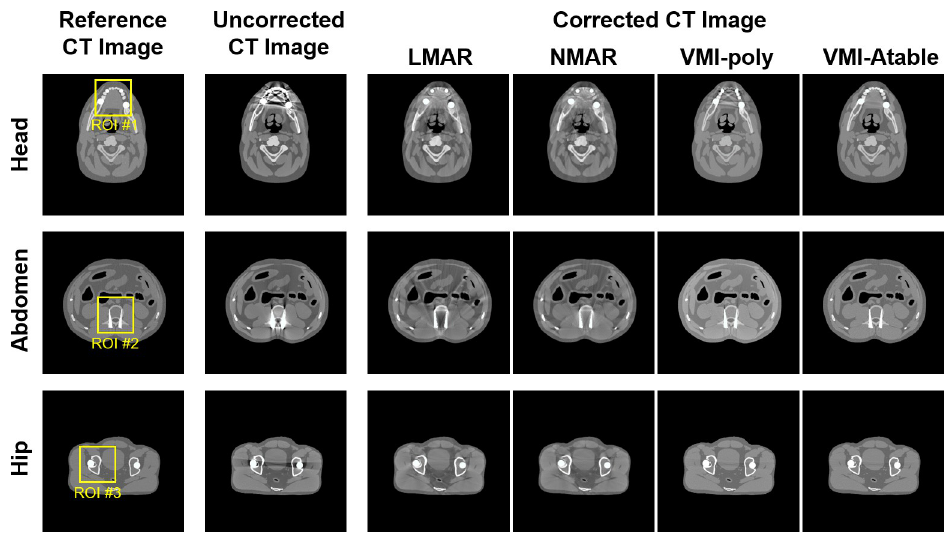
Fig 8. Simulated results using the XCAT phantom for evaluating the different MAR methods. Each row corresponds to a different part of the human body. The columns represent the reference CT image; uncorrected CT image with metal artifacts; and corrected CT images obtained using LMAR, NMAR, and the projection-based VMI algorithms (VMI-poly and VMI-Atable) at 100 keV. Window width and level of the image display are 1,000 HU and 0 HU, respectively.